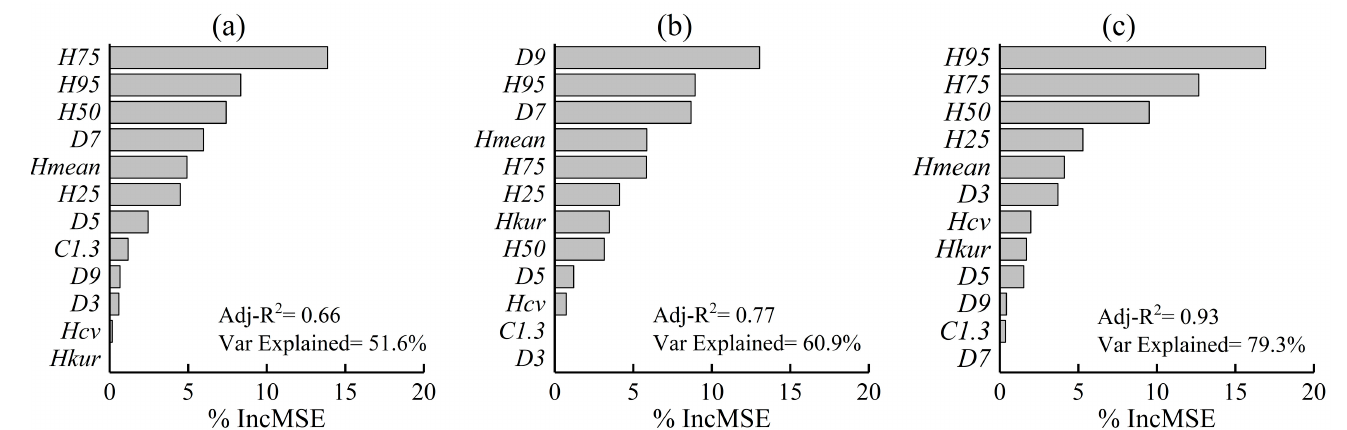
Figure 6. Variable importance and accuracy assessment of random forest-based estimation of Lorey’s mean tree height. ( a ) leaf-off dataset; ( b ) leaf-on dataset; ( c ) the fused dataset.